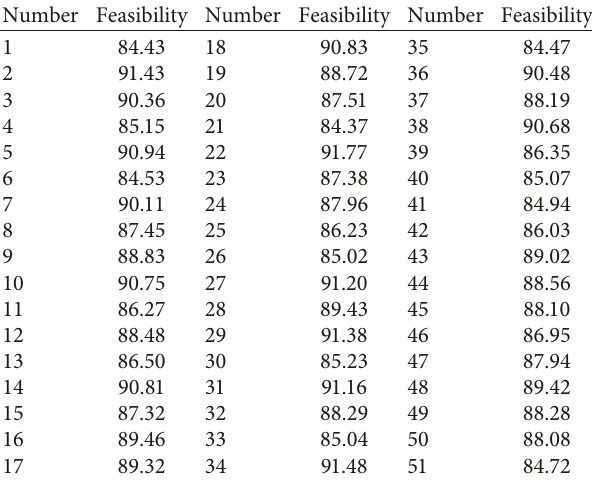
Table 2: Planning effect verification of the design method of intel- ligent public urban planning under public acceptable